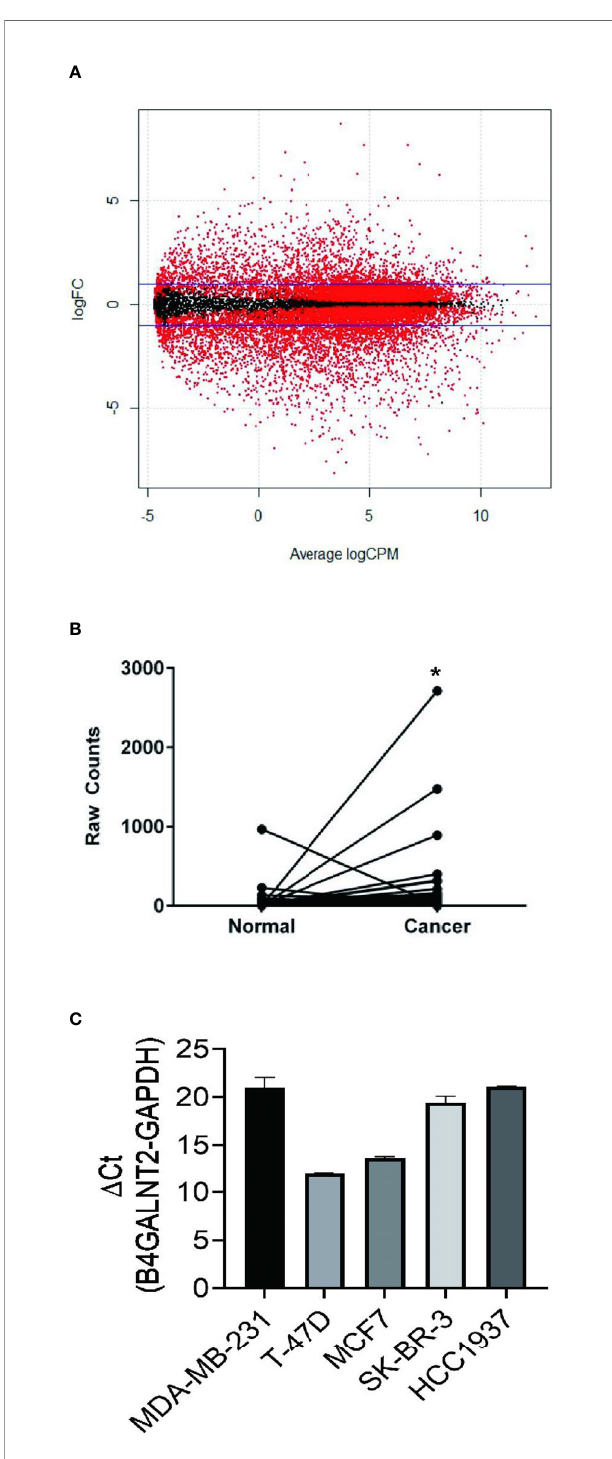
FIGURE 1 | B4GALNT2 gene is highly expressed in breast cancer tissues and cell lines. (A) The volcano map of the differential expression of genes between 1094 breast cancer tissues and non-tumor tissues (red corresponds to p<0.05; black corresponds to p>0.05). (B) A paired diagram for the expression levels of the B4GALNT2 gene in 106 pairs of breast cancer and normal adjacent tissues. (C) The relative expression level of gene B4GALNT2 in fi ve different breast cancer cell lines. *p <